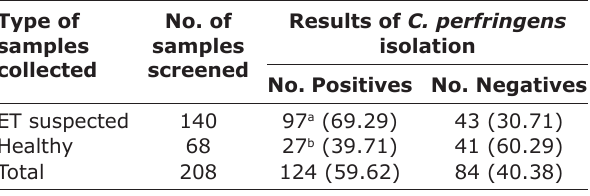
Table-2: C. perfringens isolates obtained from in enterotoxaemia suspected and healthy groups of samples. Type of samples collected